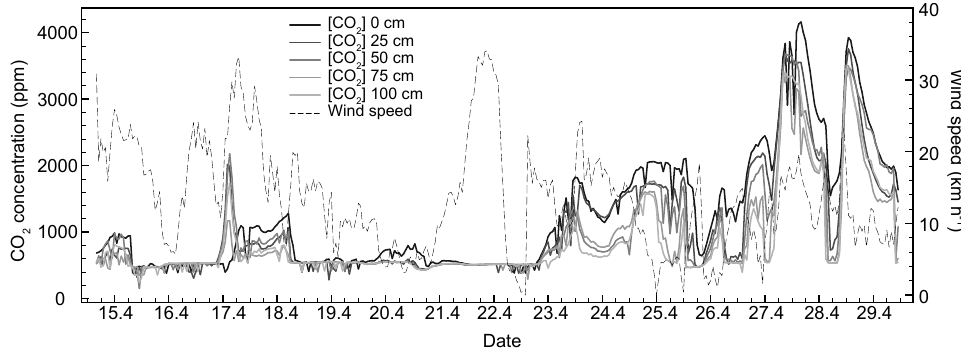
Figure 5. Time series of enhanced profiler experiment (winter 2015) CO 2 concentrations throughout the snowpack and wind speed at NM2 over 2 weeks during late winter 2015 (15 April–29 April). Measurements were recorded hourly.